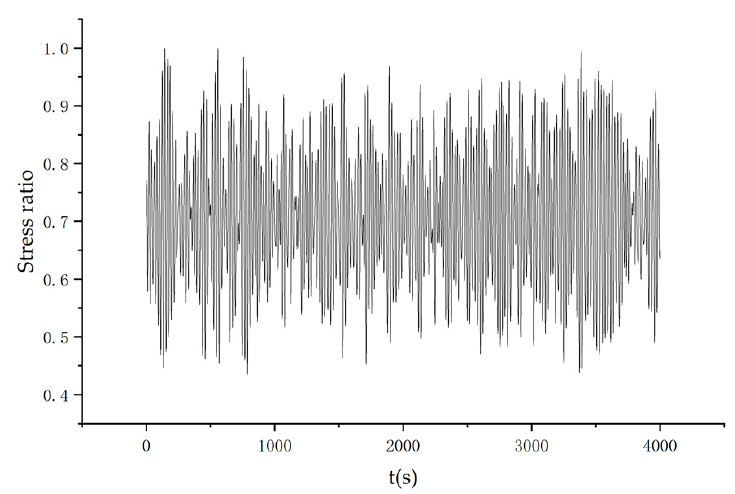
Figure 9. A stress nephogram under torsion. ( a ) The riser; ( b ) Skeleton layer; ( c ) Compressive armor layer; ( d ) Internal tensile armor layer; ( e ) External tensile armor layer.